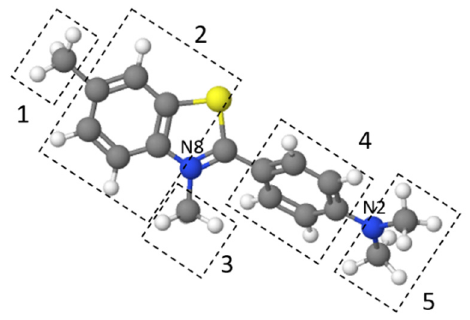
Figure 10. The structure of thioflavin T optimized using MolView. 1 and 3: methyl groups, 2: benzothiazole ring, 4: benzyl ring, and 5: dimethylamino group.